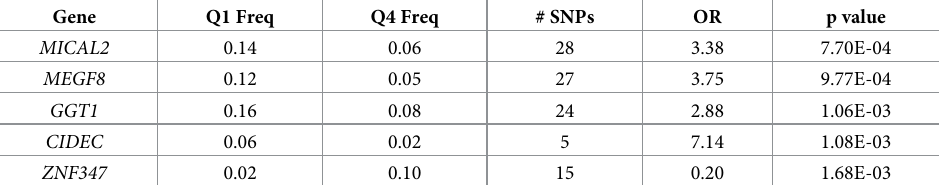
Table 2. Results from rare variant burden test comparing quartile Q1 and quartile Q4 AMD HARBOR patients. Frequencies in the columns denote the fraction of individuals in that cohort who possess any rare, functionally pre- dicted variant identified in the study. OR = odds ratio. Gene Q1